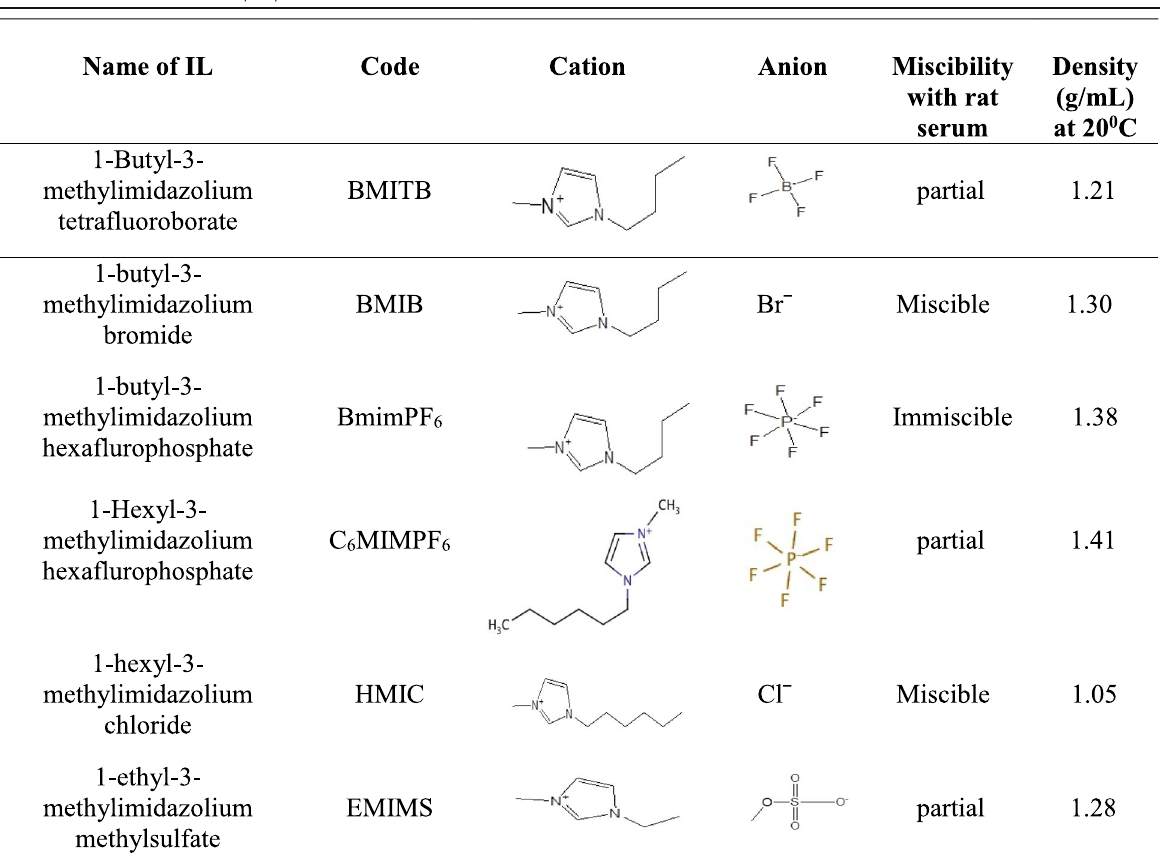
Table 1 Various ILs and their properties used in vortex-assisted